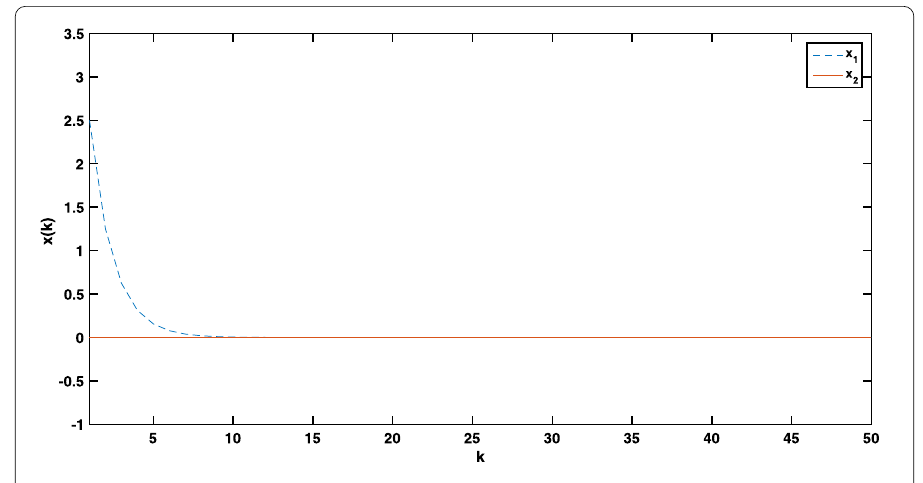
Figure 2 The trajectory of solution of system (3.2) without disturbance